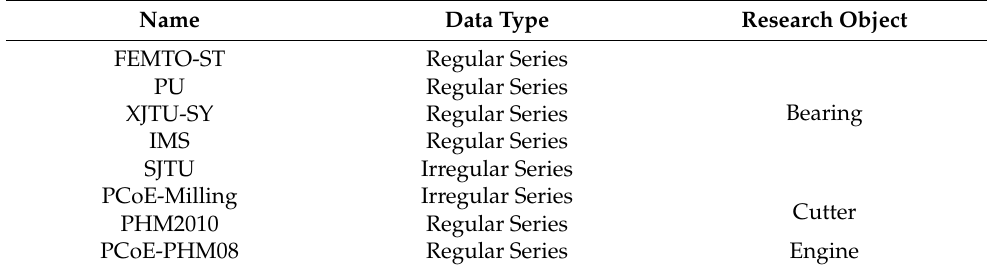
Table 4. Some available public datasets.